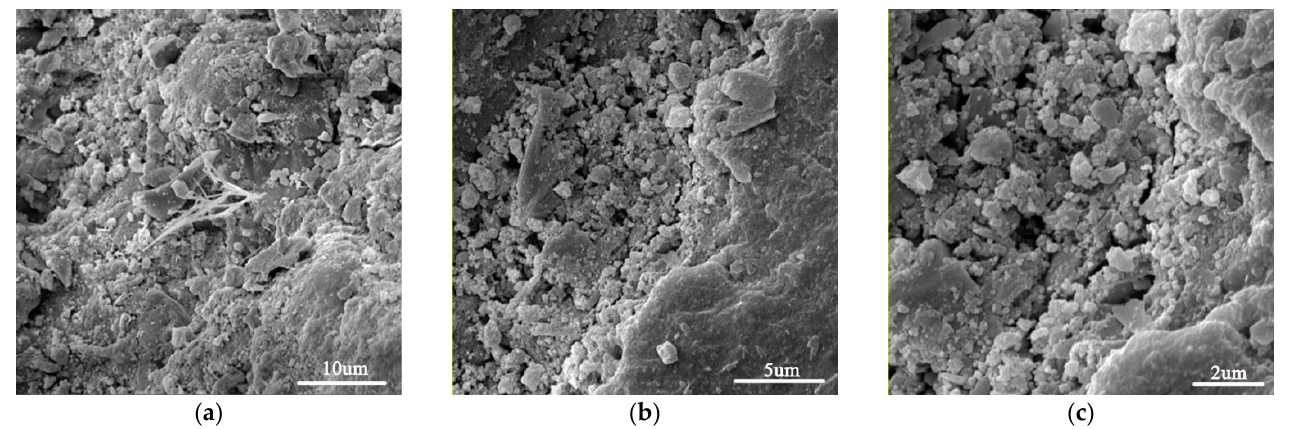
Figure 2. SEM images of plain cement mortar M ( a – c ) at different scales.